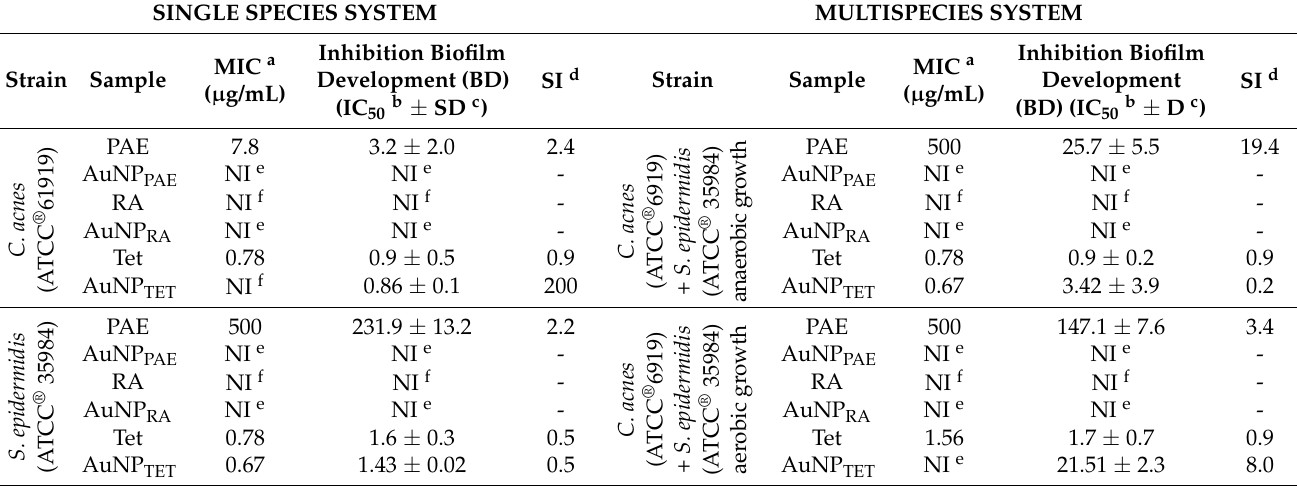
Table 1. Antibacterial and biofilm development inhibitory concentration of Plectranthus aliciae ethano- lic extract (PAE), P. aliciae gold nanoparticles (AuNP PAE ), rosmarinic acid (RA), rosmarinic acid gold nanoparticles (AuNP RA ), tetracycline, and tetracycline gold nanoparticles (AuNP TET ). The antibac- terial activity was determined against Cutibacterium acnes (ATCC ® 6919), Staphylococcus epidermidis (ATCC ® 35984), and a combination of these bacteria under anaerobic and aerobic growth